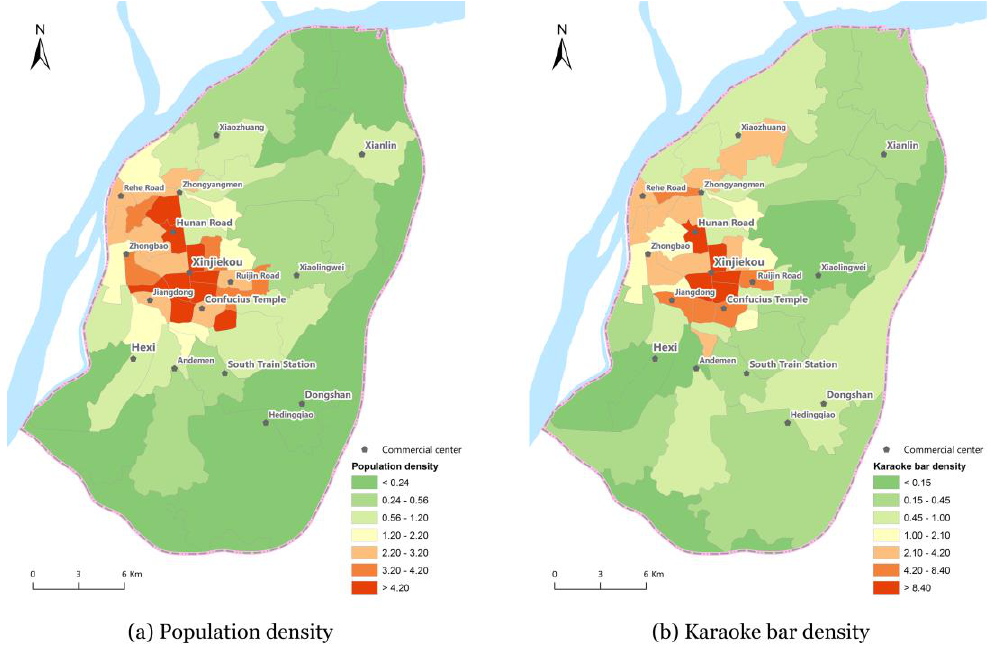
Figure 7. Density comparison at sub-district level: ( a ) Population density; ( b ) Karaoke bar density.